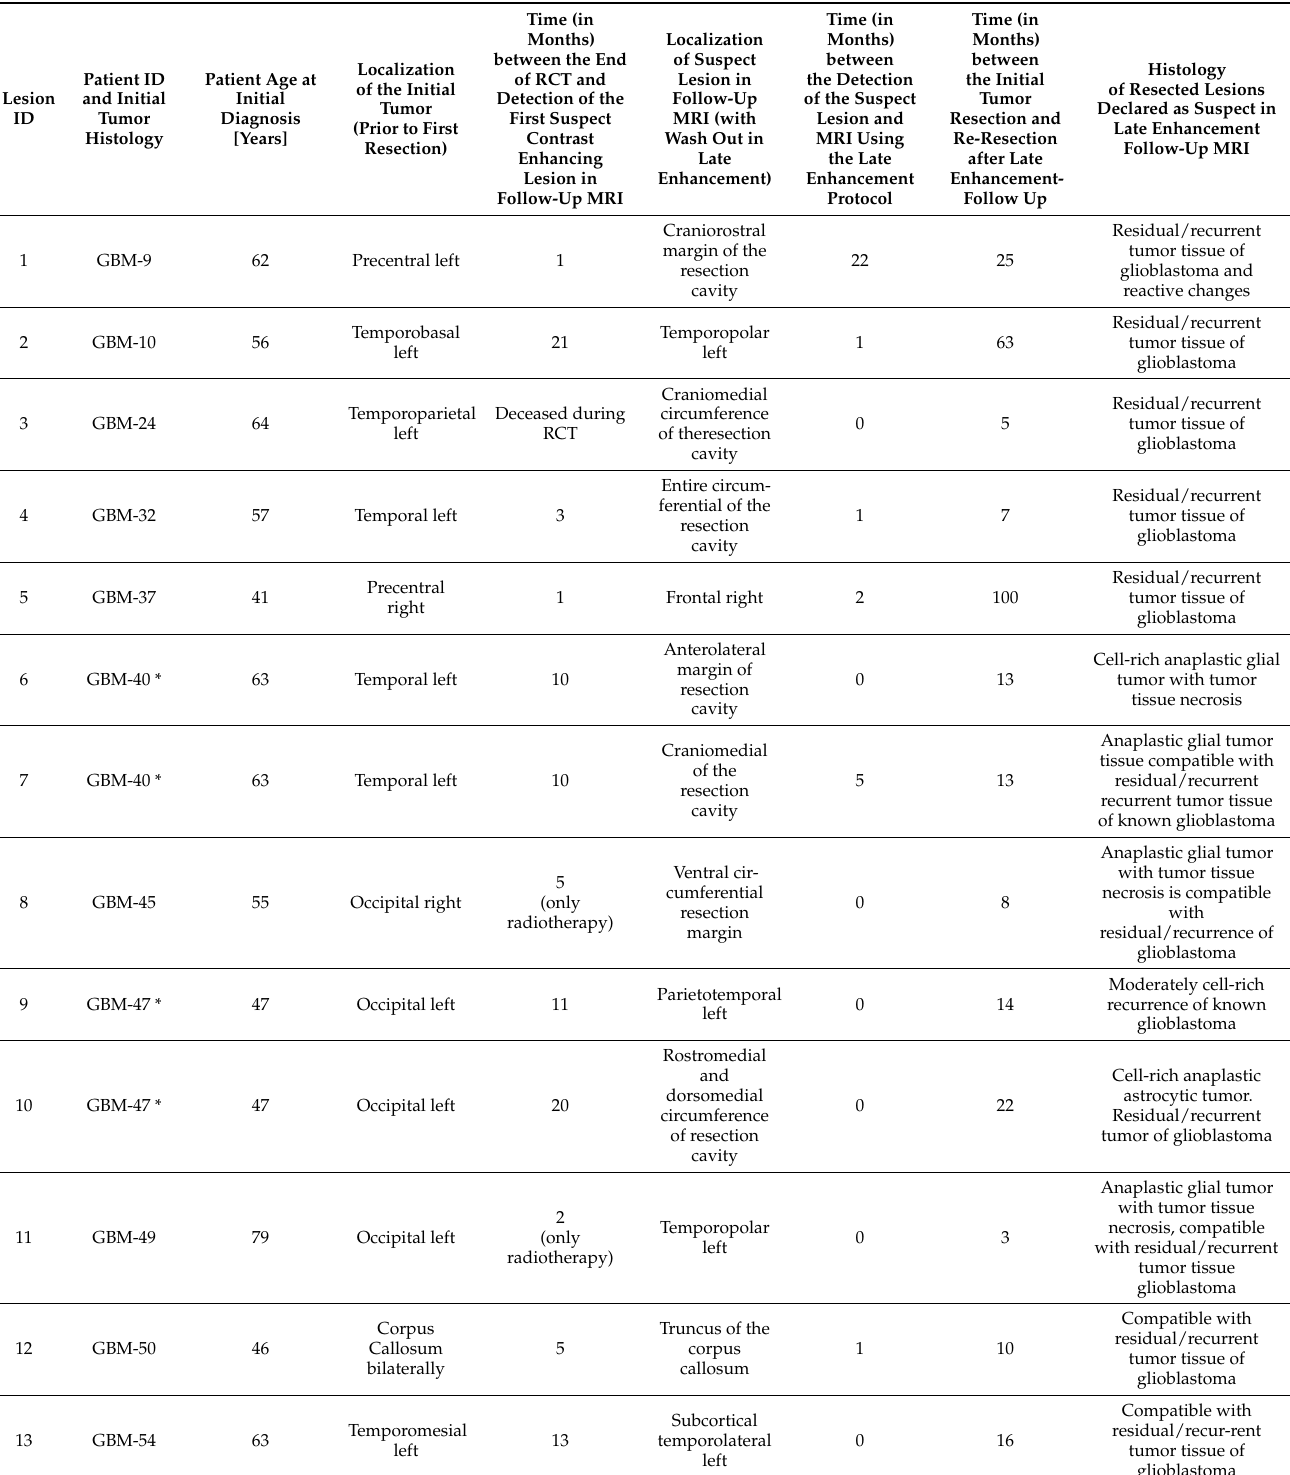
Table A1. Study population